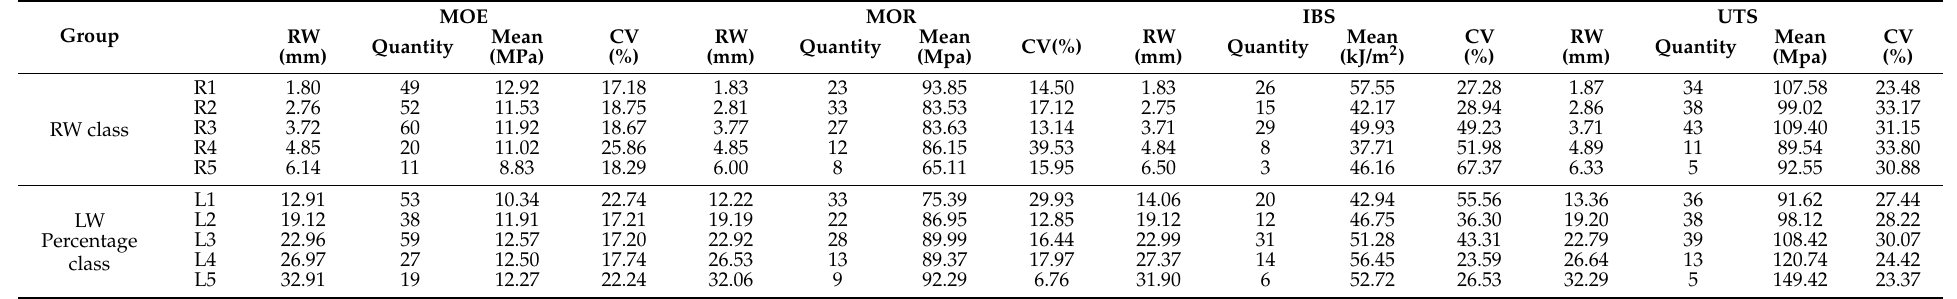
Table 2. Mechanical properties of Japanese larch for the five classifications of RW (R1 to R5) and of LW percentage (L1 to L5). See text for classification definitions. MOE: modulus of elasticity; MOR: modulus of rupture; IBS: impact bending strength; UTS: ultimate tensile stress parallel to the grain; CV: coefficient of